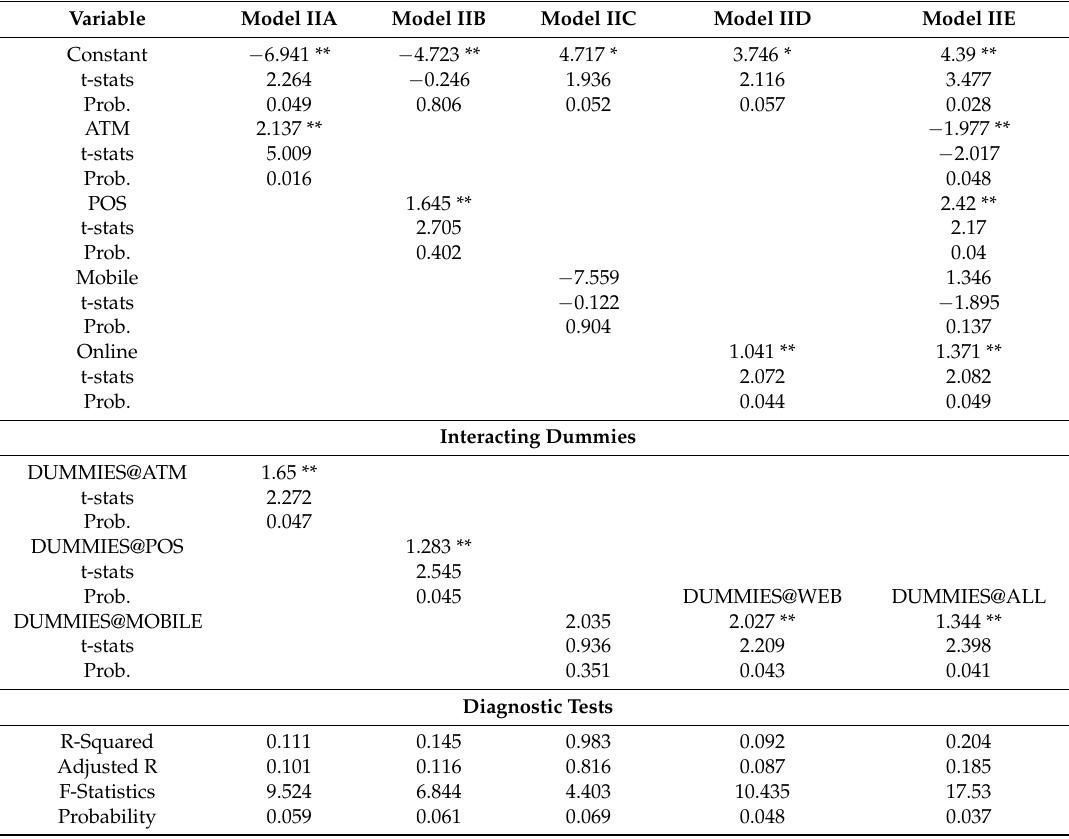
Table 6. Robustness Through Change in Specification Model II (Dependent Variable: